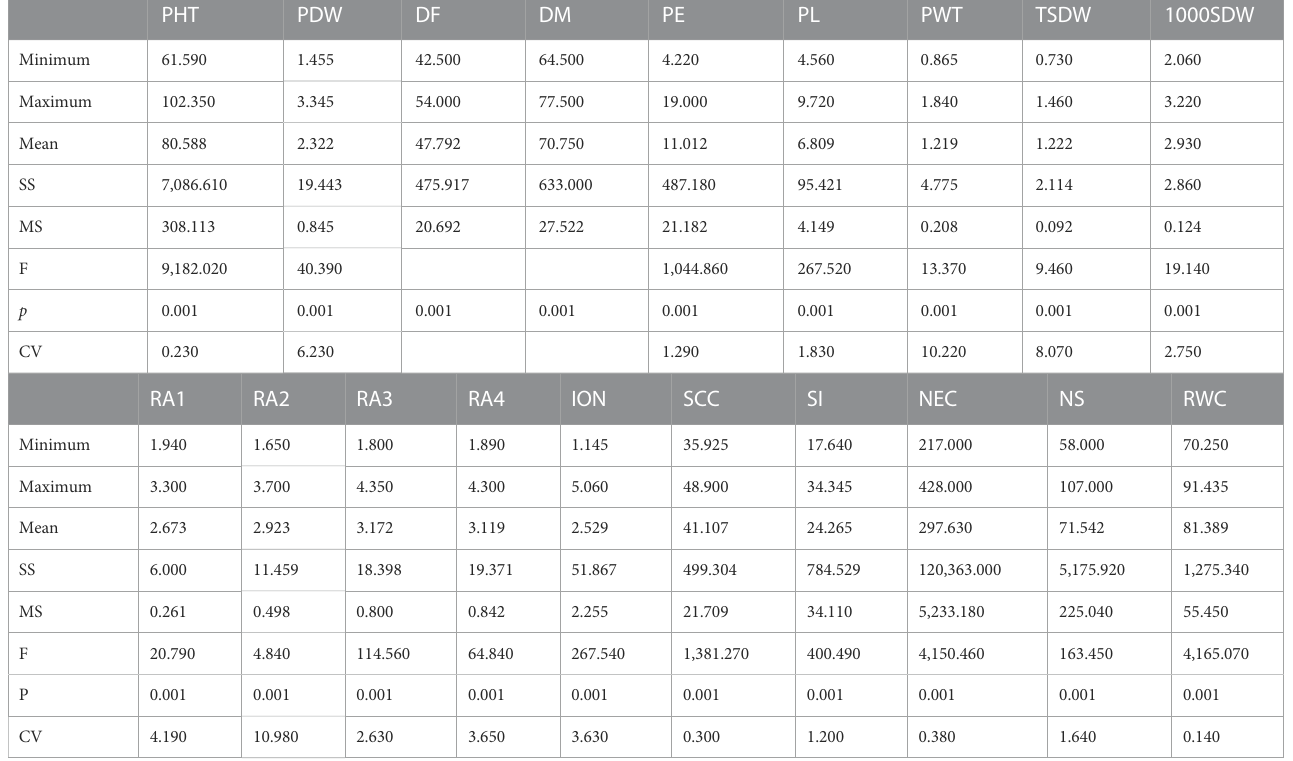
TABLE 2 Analysis of variance of studied 19 quantitative traits were evaluated on 20 foxtail millet landraces along with four released cultivars. PHT PDW DF DM PE PL PWT TSDW 1000SDW Minimum 61.590